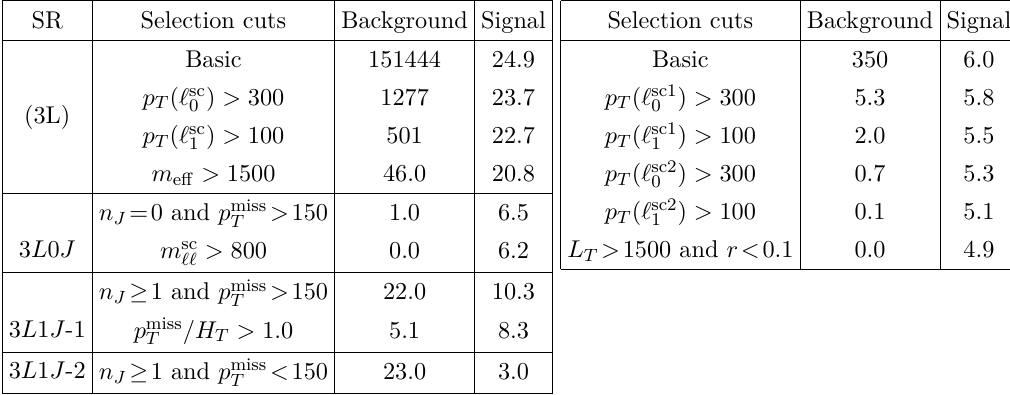
Table 2 . Left (Right): number of expected background and signal events in different 3L (4L) signal regions after passing various selection cuts for BP1 for 1000 fb − 1 of luminosity data at the 13 TeV LHC. All the dimensionfull cuts are in GeV.